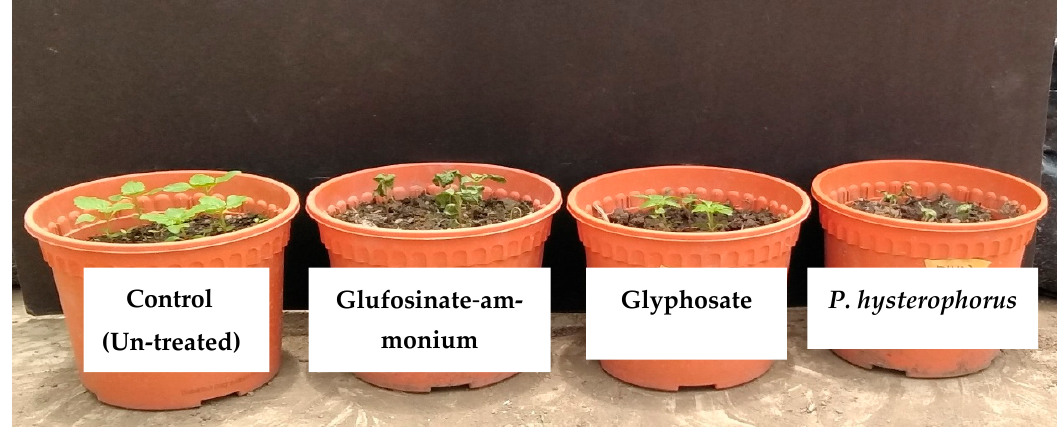
Figure 4. Effect of P. hysterophorus extract at 80 g L − 1 concentration on A. conyzoides at 24 h after spray compared with glufosinate-ammonium and glyphosate herbicides.